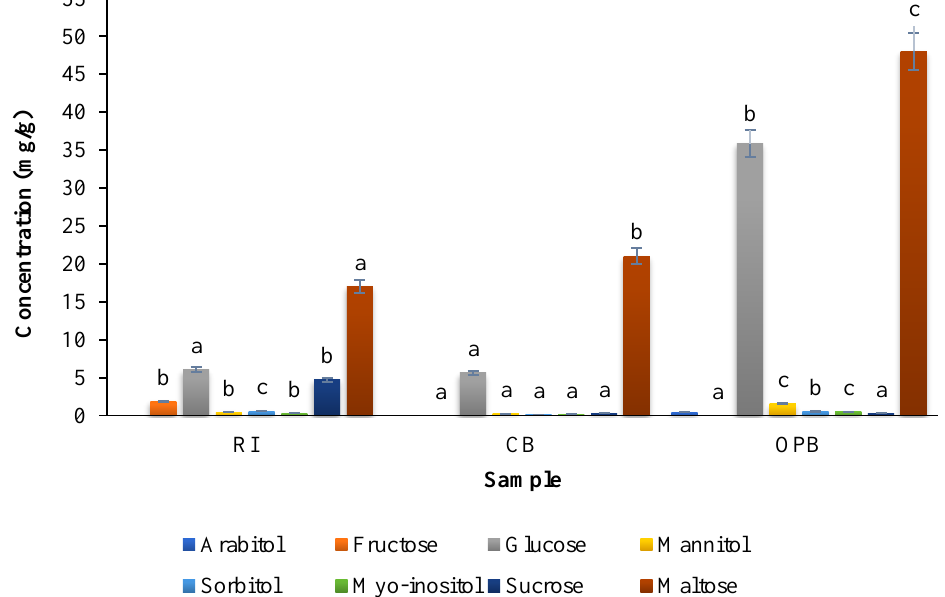
Figure 1. Sugar compounds in the mixed raw ingredients (RI), customary beer brew (CB), and optimised beer brew (OPB). Means with no common letter in the bar chart, significantly ( p ≤ 0.05) differ.